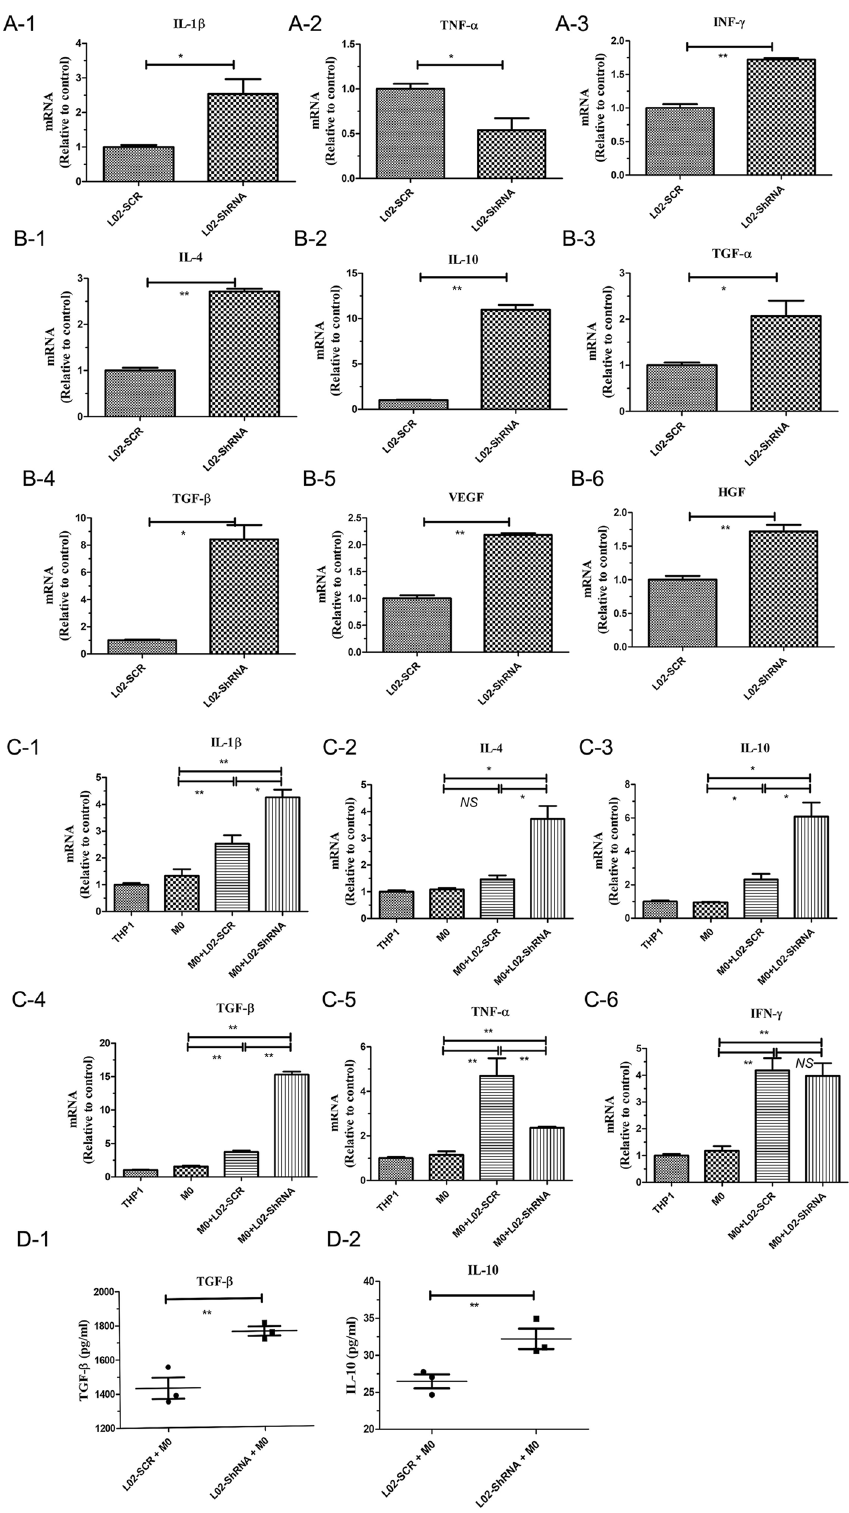
Figure 6. Silencing FPN1 increased the expression of specific biomarkers of M2 macrophages in vitro. ( A – C ) Q-PCR analysis of the expression of specific biomarkers in L02-Sh cells, L02-SCR cells + M0 macrophages, and L02-Sh cells + M0 and macrophages. ( D ) ELISA analysis of the expression of specific biomarkers in the culture medium. All results are from three independent experiments. * P < 0.05, ** P <